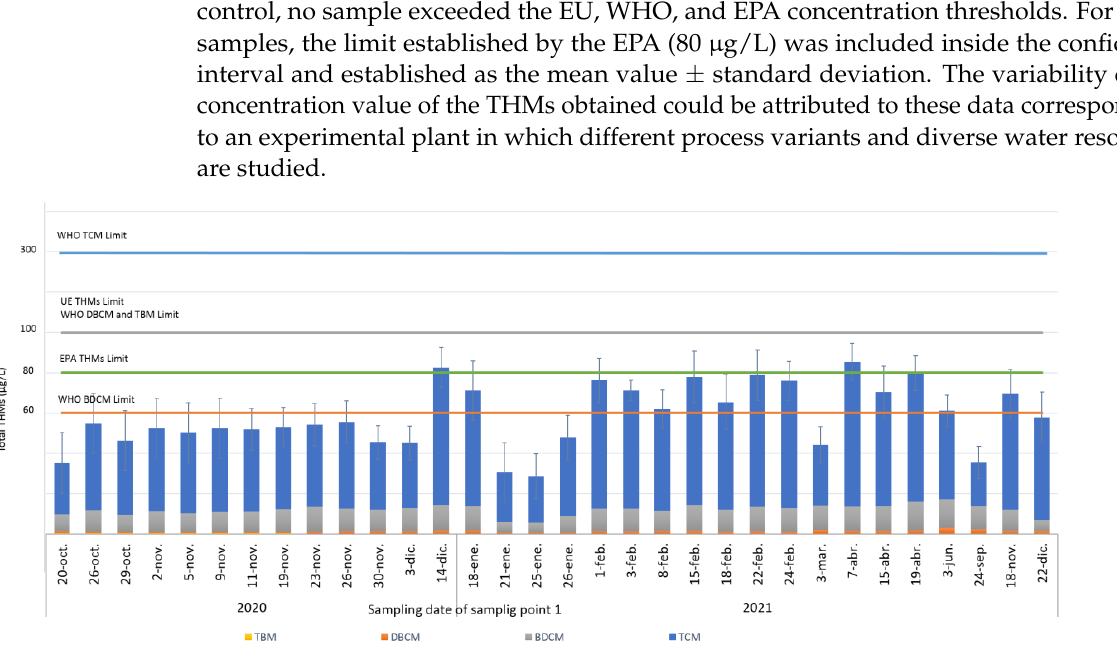
Figure 6. Variation in TCM and DOC concentration with time of raw water, obtained for the para- metric analysis of GAC sorption capacity at 1.5 g/L concentrations of GAC and three temperatures. In Figure 6, it can be observed that an increase in temperature favors the removal of DOC and TCM. This result can be explained because the diffusional phenomenon in- volved in the adsorption is highly dependent on temperature. Consequently, the temper- ature increase favors the retention adsorption kinetics of both compounds. The high sen- sitivity of the HS-SPME-GC/MS developed method allows the low levels of concentration of TCM to be monitored and obtained along with the parametric analysis. A pseudo-second-order kinetics was obtained for the adsorption of TCM and DOC on GAC with good regression coefficients, noting the enormous differences in the adsorp- tion kinetic constant between both parameters. For example, at a temperature of 15 °C,